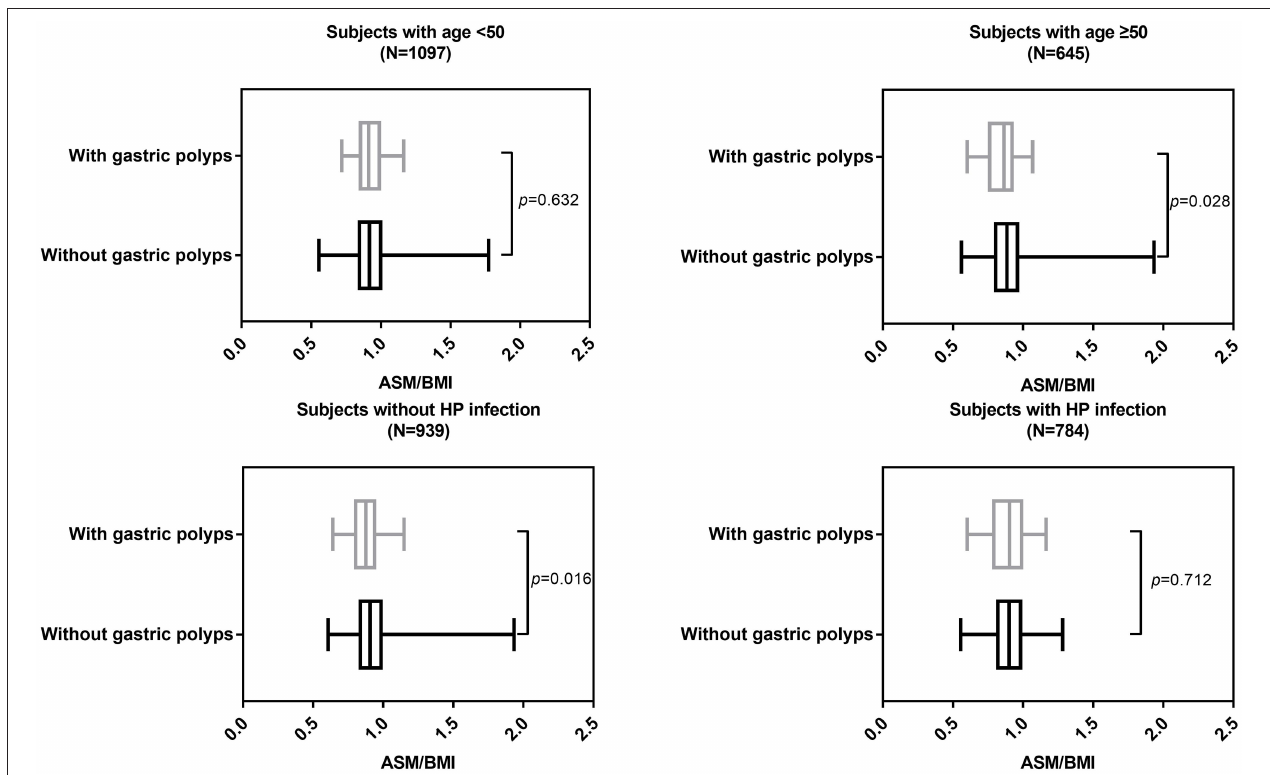
FIGURE 2 | ASM/BMI of individuals with and without gastric polyps in different subgroups.